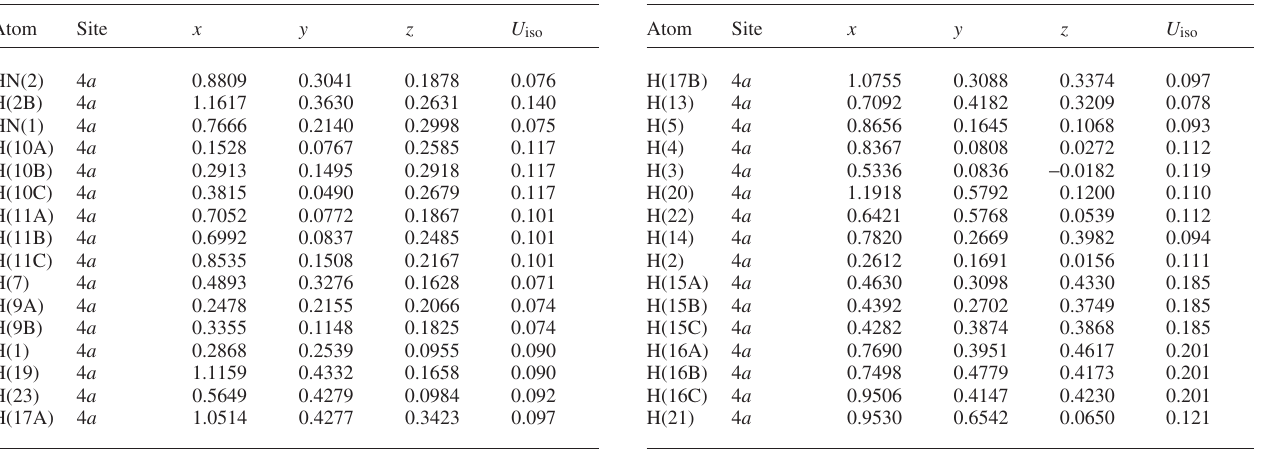
Table 2. Atomic coordinates and displacement parameters (in Å 2 )